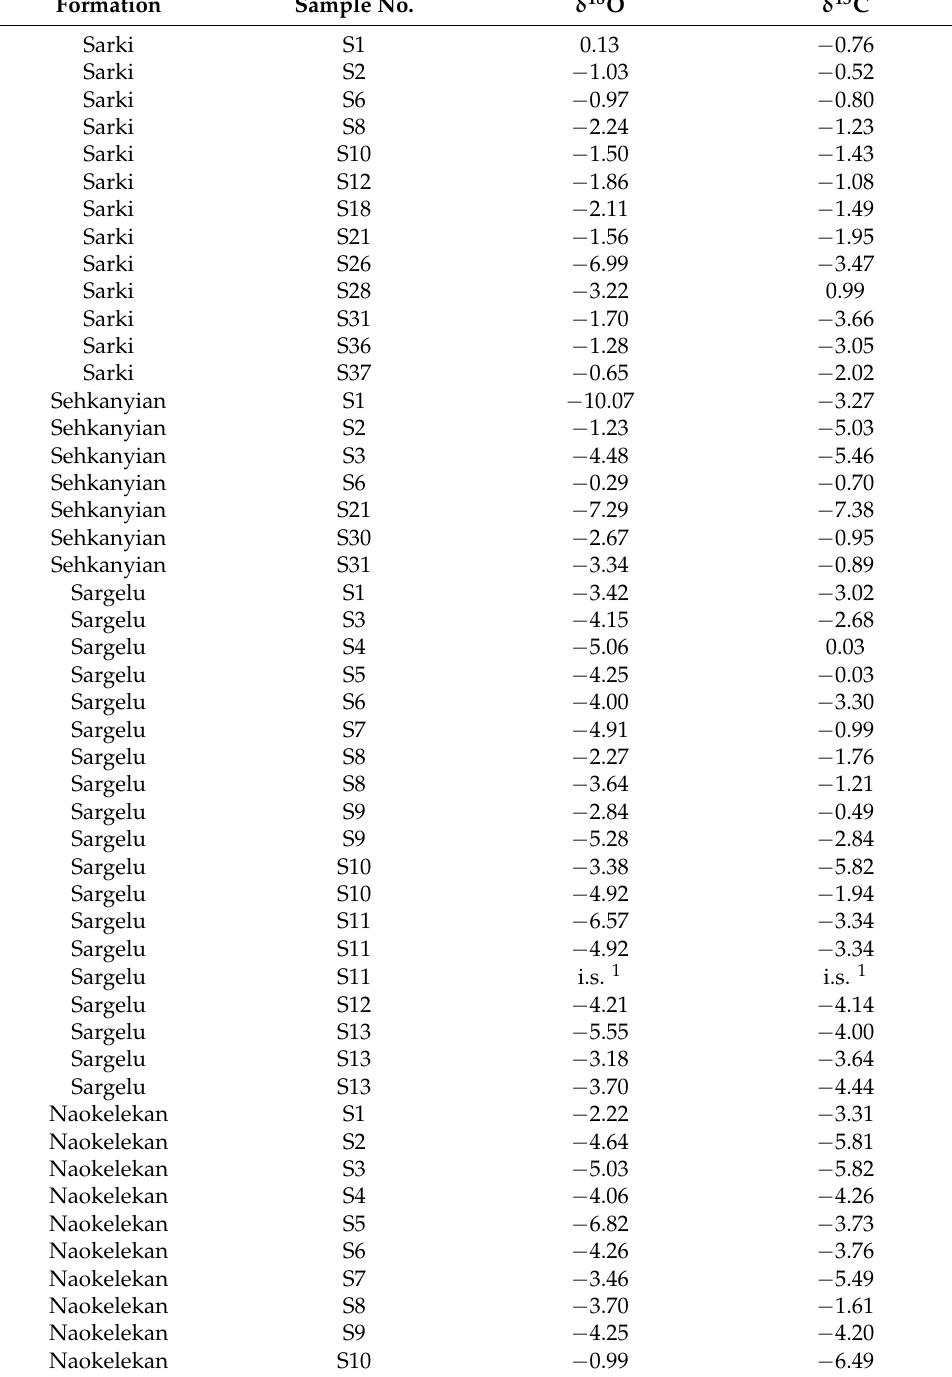
Table 2. Oxygen isotope ( 18 O) and carbon isotope ( 13 C) data for the samples from the Sarki, Sehkaniyan, Sargelu, Naokelekan, Barsarin and Chia Gara formations. Formation Sample No. δ 18 O δ 13 C Sarki